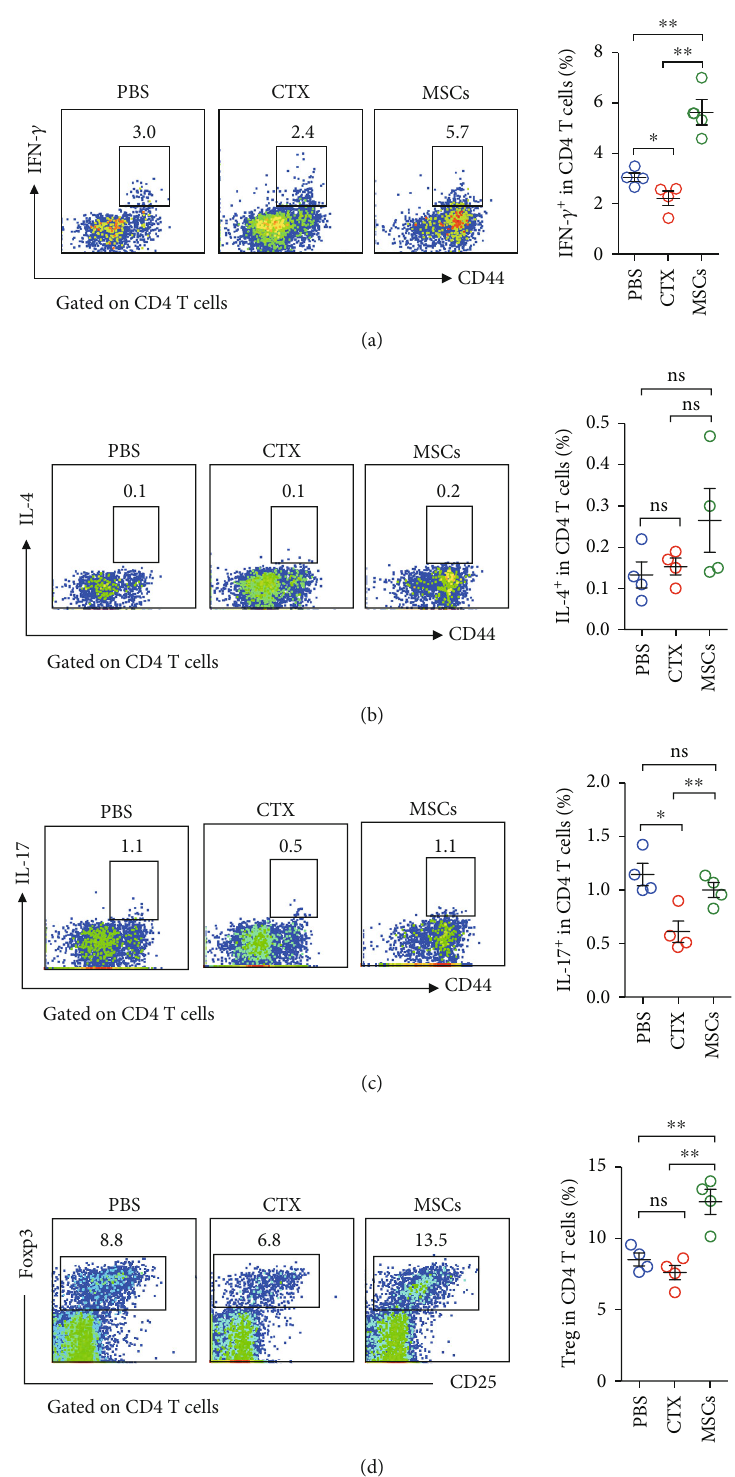
Figure 4: Treatment with MSCs signi fi cantly increased Treg and Th1 cells in the lung. Mice were treated with MSCs or CTX as described above. Lung cells were isolated and stimulated with PMA and ionomycin for fi ve hours. Cytokine production by CD4 T cells was determined by intracellular staining. Percentages of IFN- γ (a), IL-4 (b), and IL-17 (c) producing cells were shown. (d) Tregs in the lung were determined by intracellular staining. Data were expressed as the means ± SEM . n = 4 mice for each treatment group. ∗ p < 0 : 05 ; ∗∗ p < 0 : 01 ; ns: no signi fi cant di ff erence. This experiment is representative of three individual